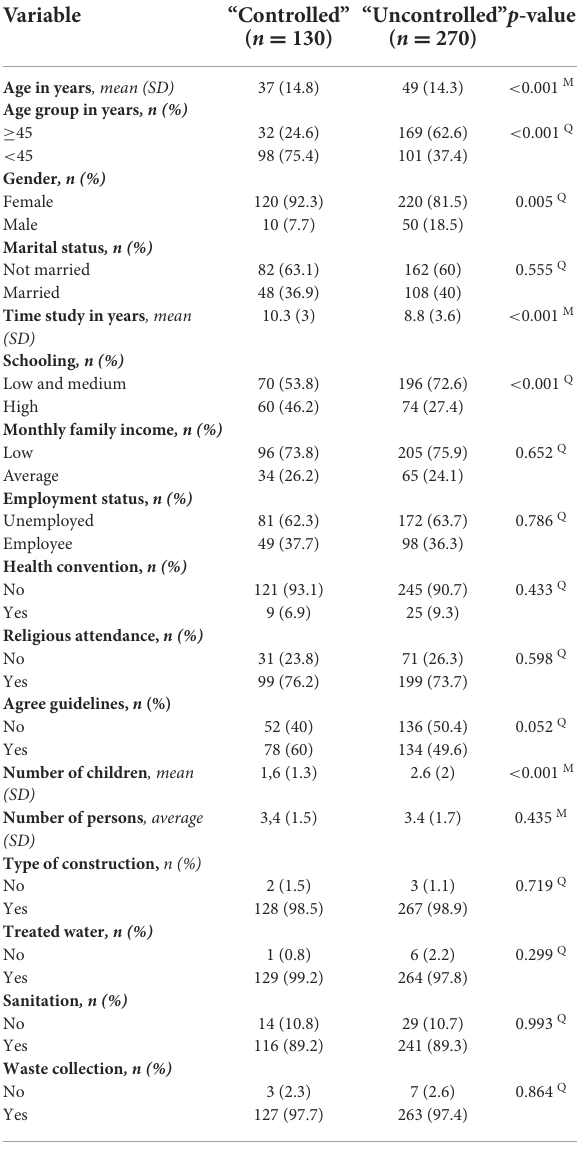
TABLE 2 Dichotomization of the classification “Controlled” ( ≥ 5 ideal metrics in CVH) and “Uncontrolled” ( < 5 ideal CVH metrics) by variables ( n = 400).